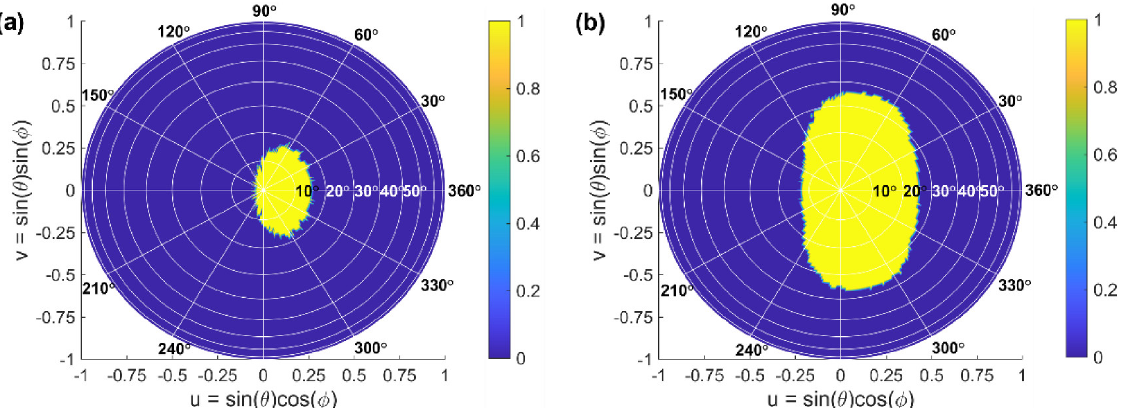
Figure 8. Projection of a steering range for ( a ) Array #1 and ( b ) Array #2 , both operating at C -band wavelengths. The yellow area represents the set of all steerable angles, where the sidelobe suppression is larger than 10 dB, and the blue area represents non-steerable angles.